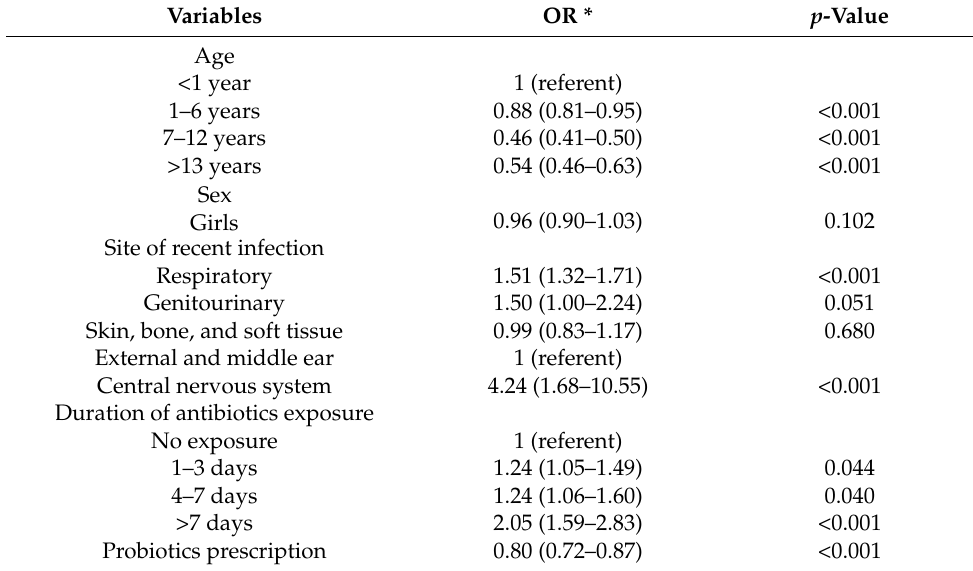
Table 3. Multivariable logistic regression model of hospitalisation within a